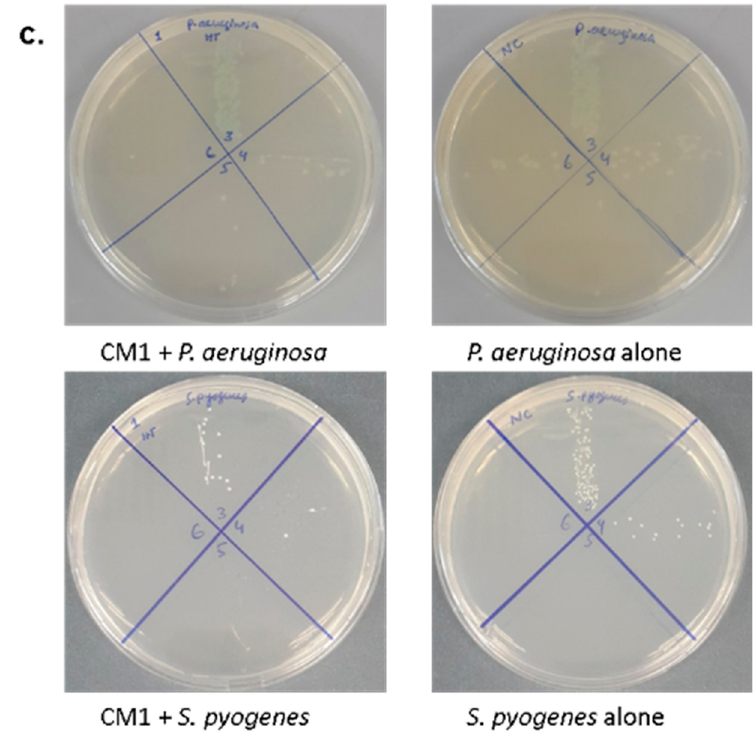
Figure 3. Heat treated CM from water monitor lizard (WML) gut possessed antibacterial properties against S. pyogenes and P. aeruginosa . Briefly, 1 × 10 6 bacteria were incubated with heat-inactivated CM at 37°C for 2 h. Next, the culture was serially diluted, plated on nutrient agar and plates were incubated at 37°C for 24 h. Next day, bacterial viability was measured by enumerating viable bacterial colonies. All the experiments were performed several times in duplicate and P values were determined using student’s t-test. (*) represents P ≤ 0.05. ( a ) CM tested against P. aeruginosa ( b ) against S. pyogenes , and ( c ) representative effects of CM against P. aeruginosa and S. pyogenes .